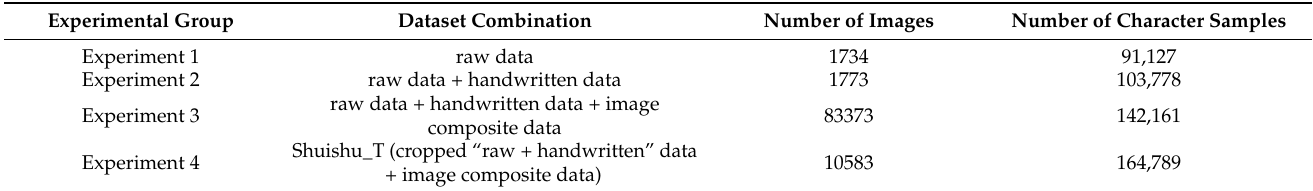
Table 6. Dataset information of each experiment.